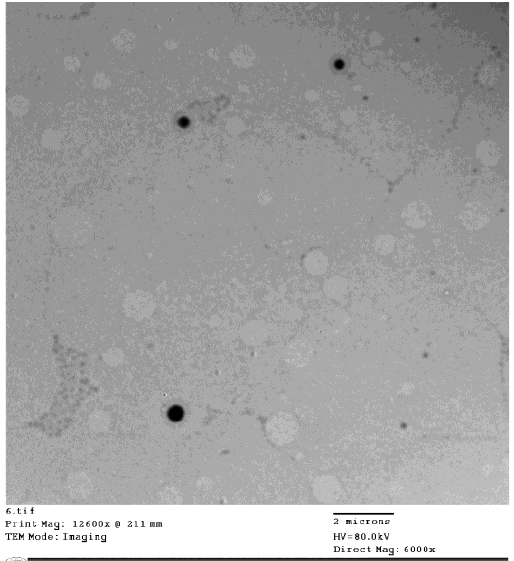
Figure 2. Morphology and size of caffeic acid phenethyl ester (CAPE)-optimal liposomal formula- tion (CAPEL) using transmission electron microscope (TEM) ( n = 1).